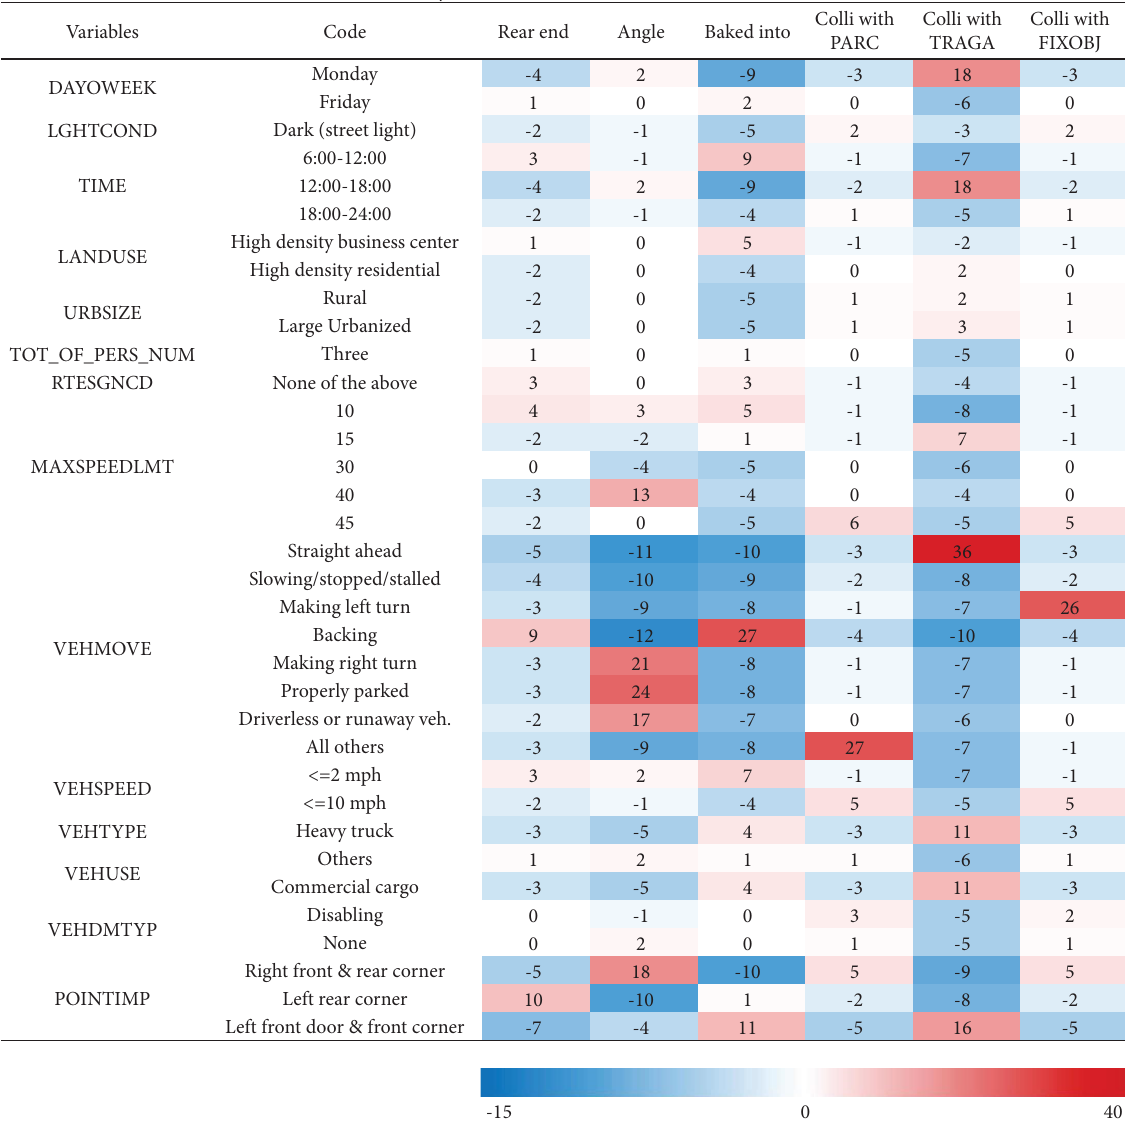
Figure 6: Conditional probability of target nodes for parking lot accidents considering (a) property damage and (b) event cause. Te “Colli with PARC,” “Colli with TRAGA,” and “Colli with FIXOBJ” are short for “Collision with the parked car,” “Collision with trafc gate,” and “Collision with a fxed object above the